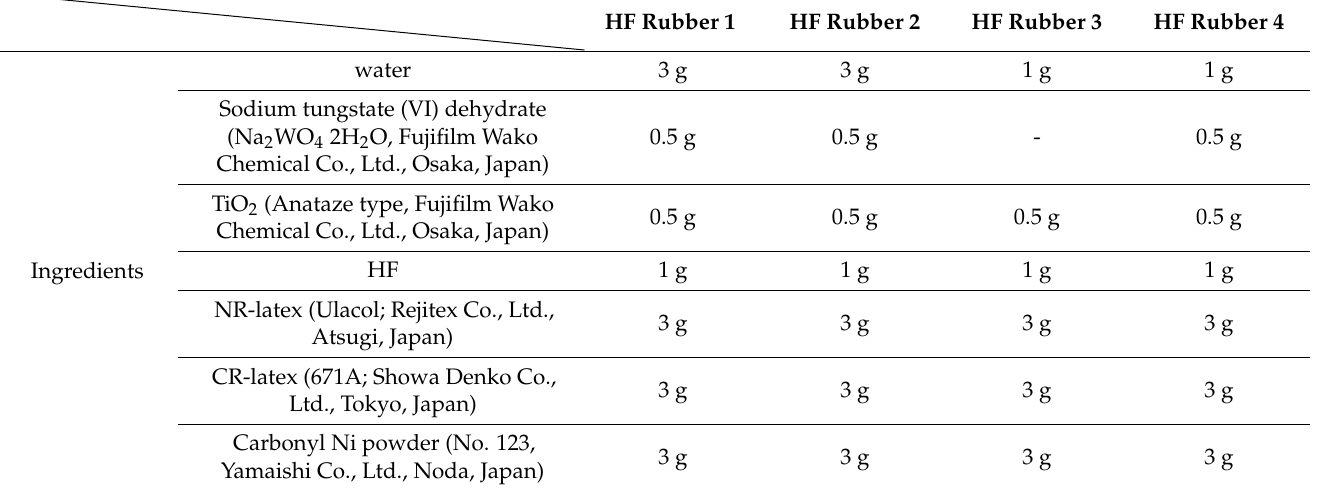
Table 1. Ingredients of HF rubber for the fabrication of the gustatory